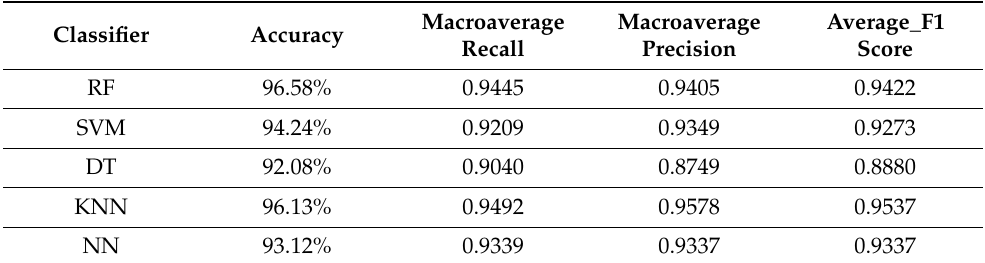
Table 2. The performance of the classifiers.